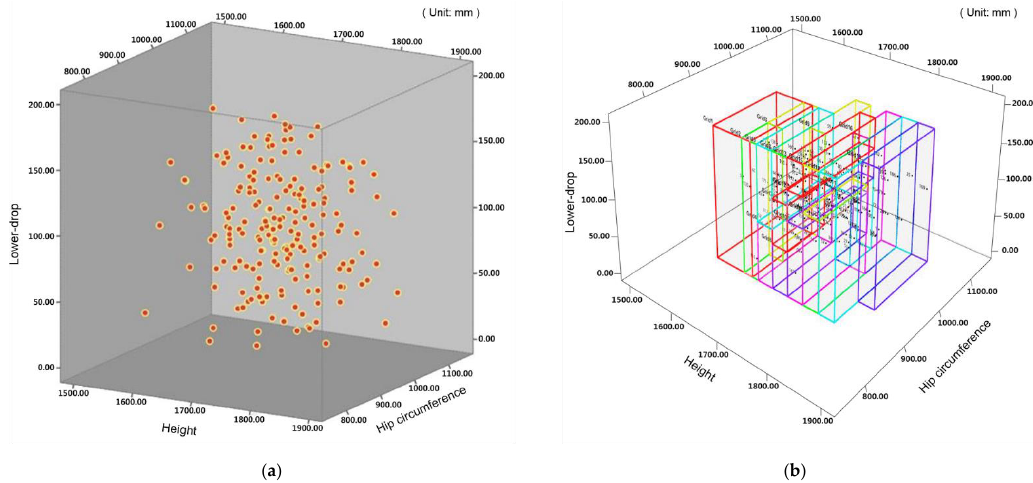
Figure 4. Results of representative grid method: ( a ) results of 3D scatter plot generation and ( b ) result of formation of representative grid by size section. When generating the sizes of important variables for each representative grid, the mean height, hip circumference, and lower-drop values of the sample data included in each representative grid were calculated to generate the size of important variables for each representative grid, as shown in Table 9, and the generated size of important varia- bles was used as the reference size for selecting the template model in the process of av- erage human body model generation. Table 9. Dimensions of important variables by representative grid. Section